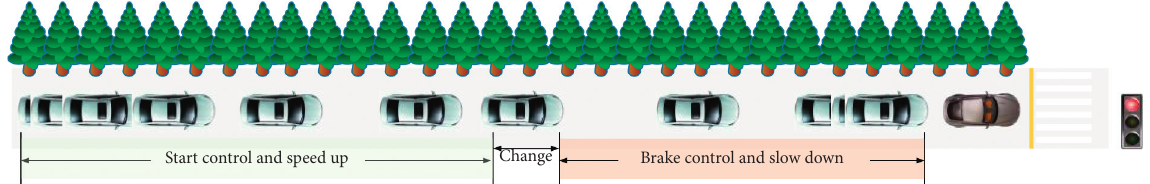
Figure 2: The experimental scenario.